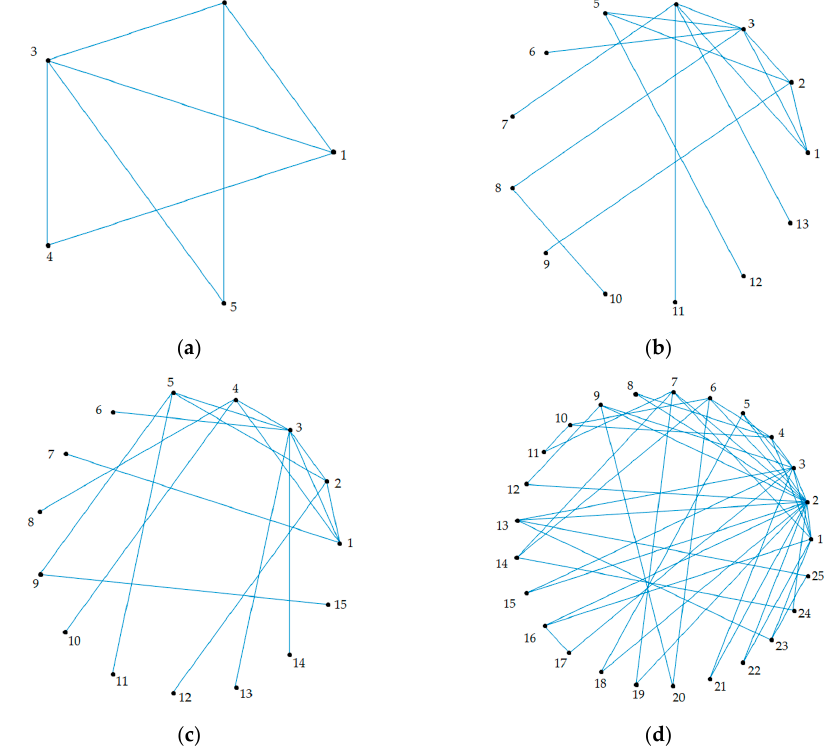
Figure 16. Network topologies used for simulations, consisting of: ( a ) 10 nodes; ( b ) 13 nodes; ( c ) 15 nodes; ( d ) 25 nodes. Table 2. Passivity degree values for the different chaotic systems.